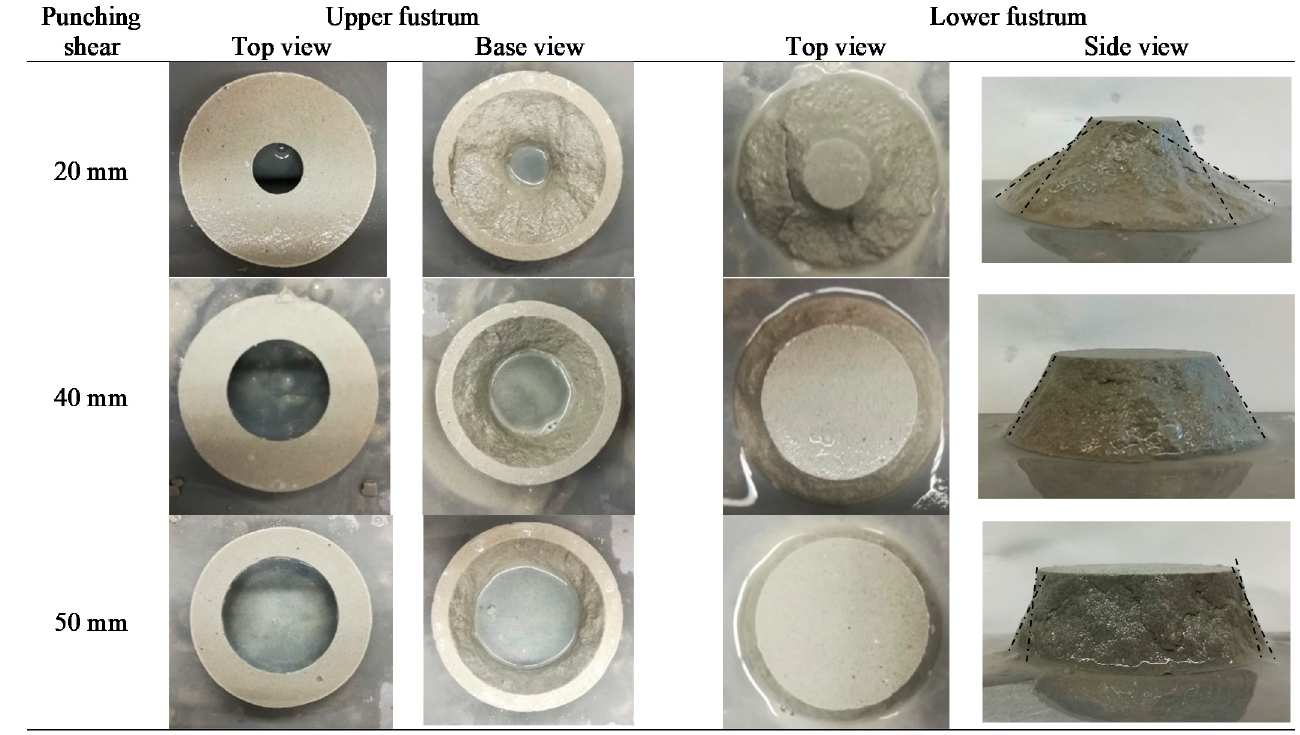
Figure 6. Typical fracture morphology of the 20, 40, and 50 mm diameters of the puncher